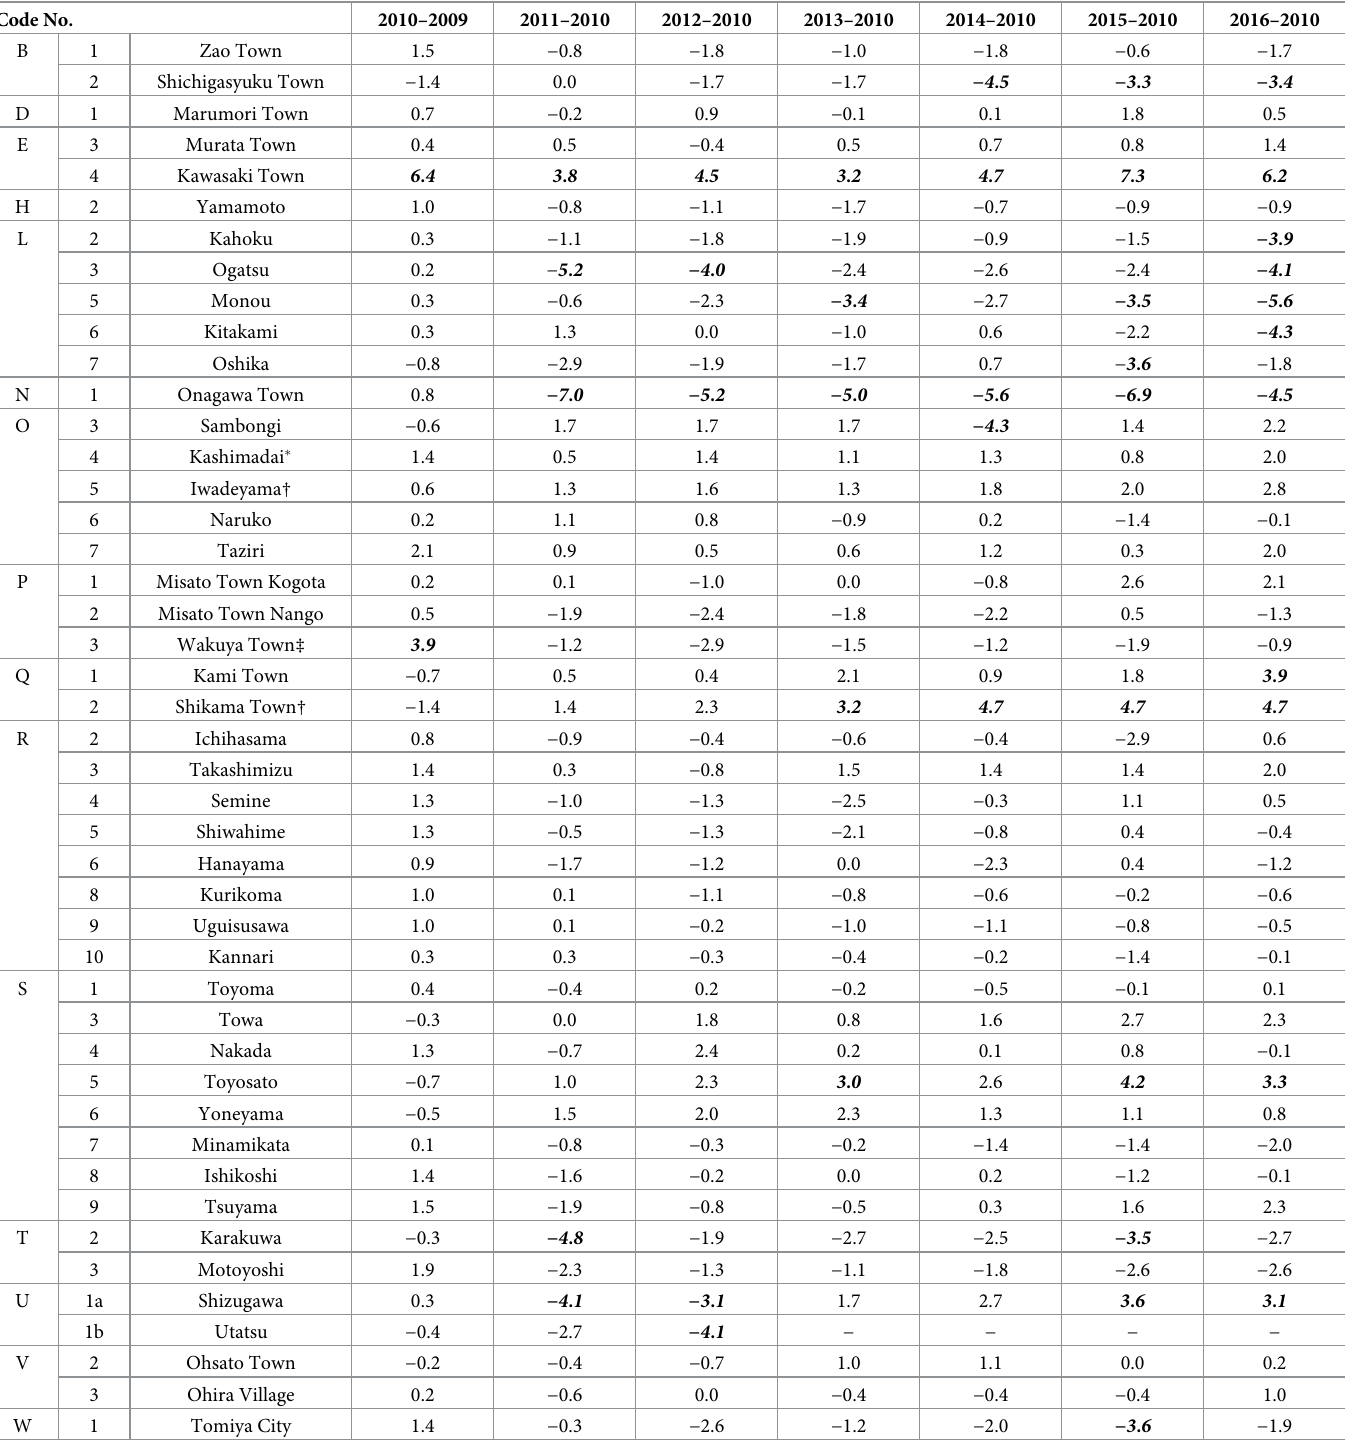
Table 1. Differences in the cervical cancer screening rates between before and after the Great East Japan Earthquake. Code